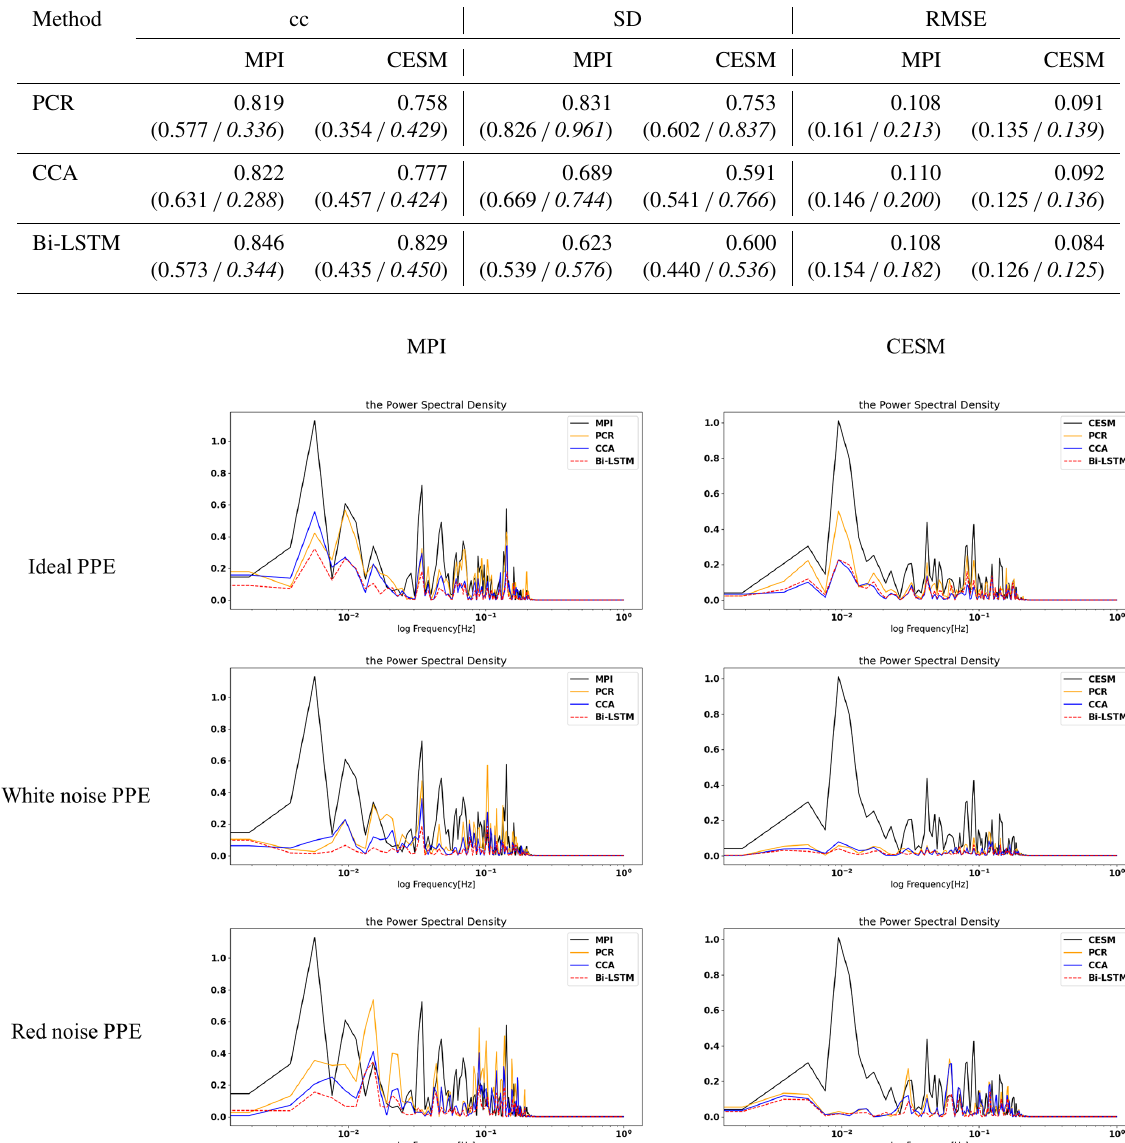
Table 3. The same as Table 2 but for the decadal AMV index.